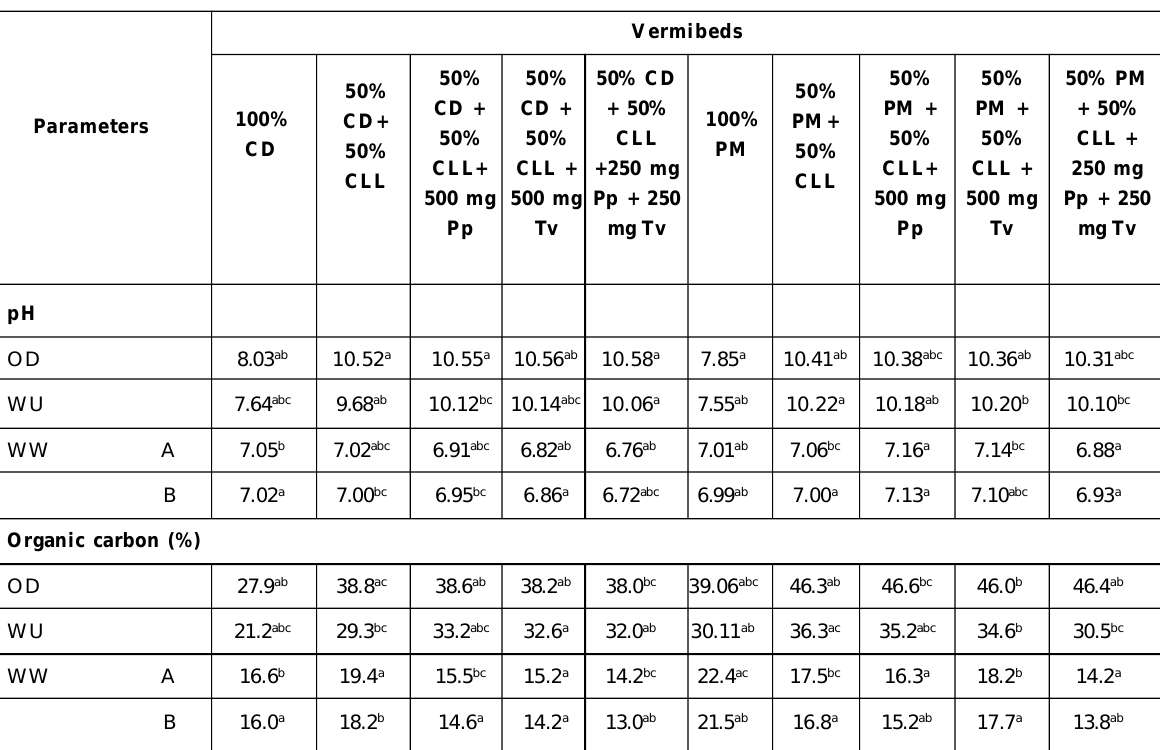
Table 3: Chemical composition of vermifertilizer obtained through integrated system of vermicomposting — lignocellulosic wastes (n=6; X